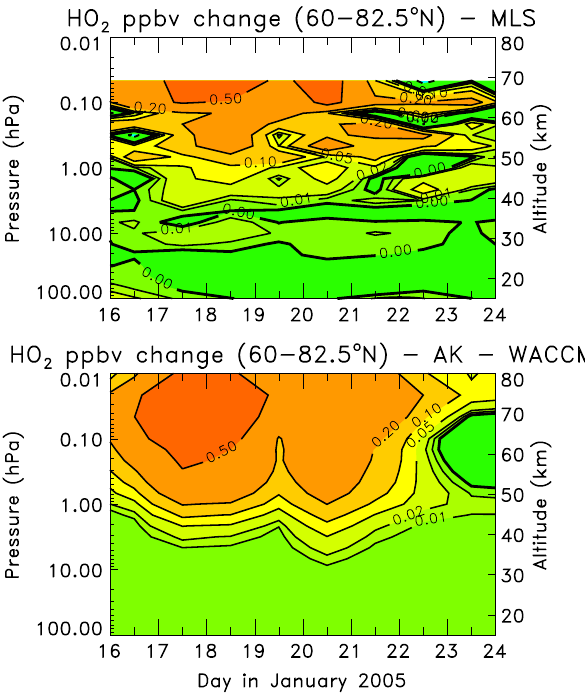
Fig. 7. Daily averaged ozone changes from Aura MLS measure- ments (top) and WACCM3 B average predictions (bottom) for the 60–82.5 ◦ N band. An average observed (predicted) ozone profile for the period 1–14 January 2005 was subtracted from the observed (predicted) ozone values for the plotted days (16–23 January 2005). The contour intervals for the ozone differences are − 80, − 60, − 40, − 20, − 10, − 5, − 2, − 1, 0, 1, 2, 5, and 10%. The MLS averaging kernel (AK) was used to sample the WACCM3